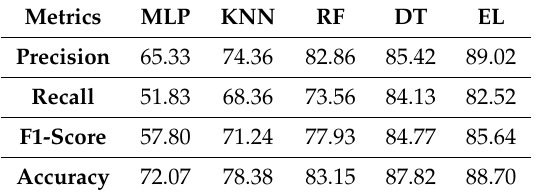
Table 6. Average cross validation score of each model (20-min prediction validity with an 80% threshold). Metrics MLP KNN RF DT